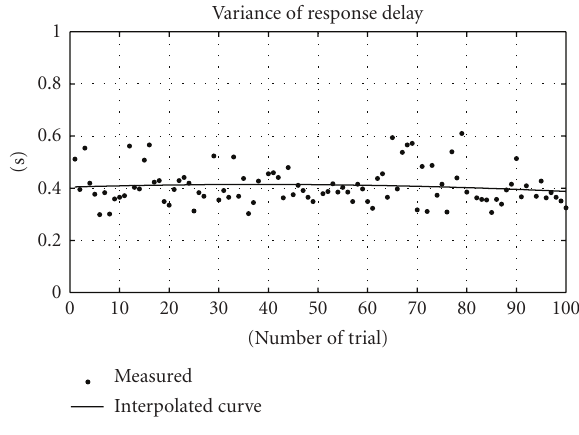
Figure 7: Variance of response